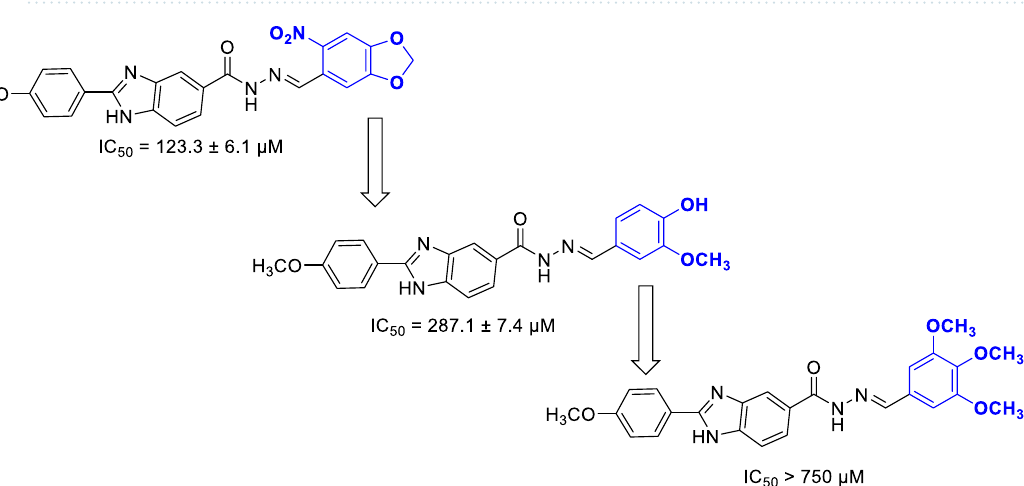
Scheme 2. Inhibitory activities of the un-substituted derivatives and derivatives with one substituent on phenyl ring linked to the Schiff base